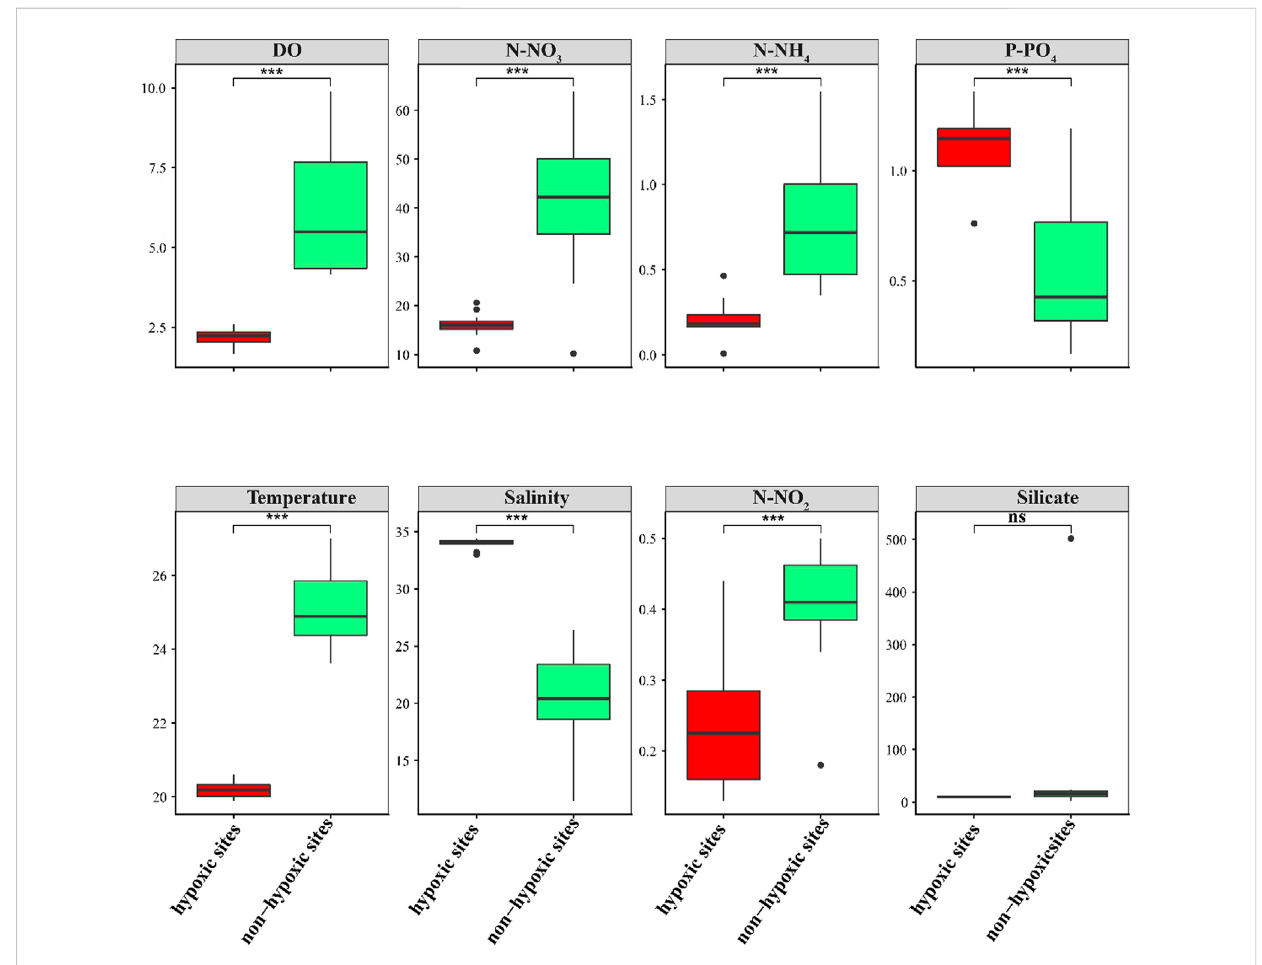
FIGURE 2 Box plots of the environmental factors between the hypoxic and non-hypoxic